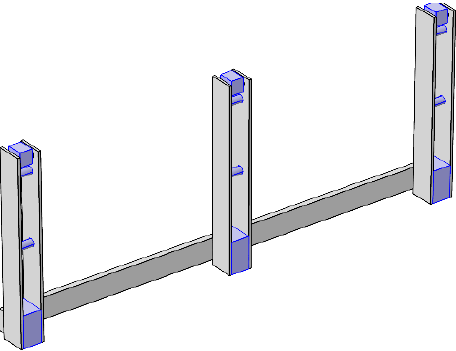
Figure 10. Simplified 3D model in COMSOL Multiphysics (5.2, COMSOL, Inc, Stockholm, Sweden); blue colour—domains on which boundary condition u = 0 is imposed.